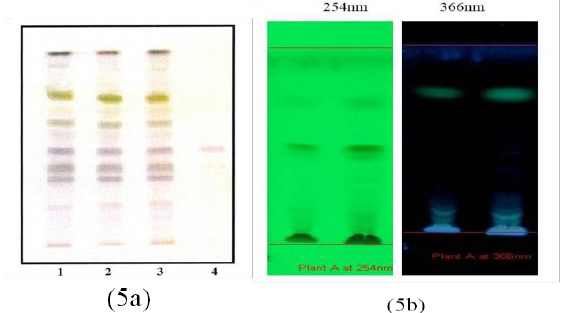
Figure 5a & 5b: TLC profile of test solution of N. arbor- tristis leaf. In Figure 5a, 1-3:test solution, 4: N. arbor- tristis standard. Figure 5b represents photo documentation report of hydro-alcoholic extract of N. arbor-tristis at 254 nm and 366 nm.